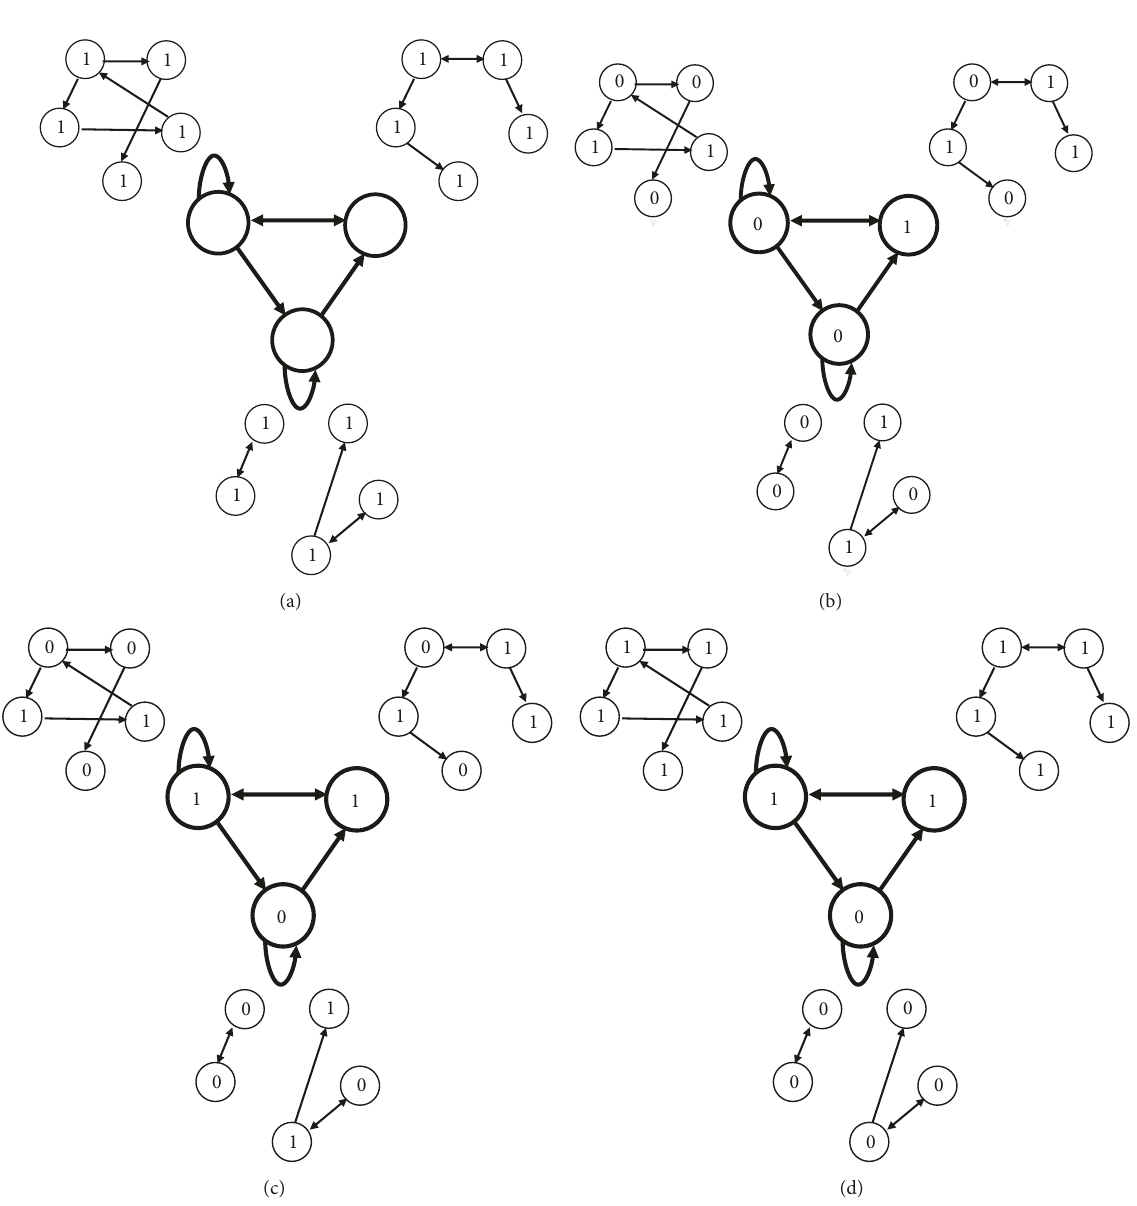
Figure 4: Schematic diagrams illustrating the updates of the node states in a multilayer RBN